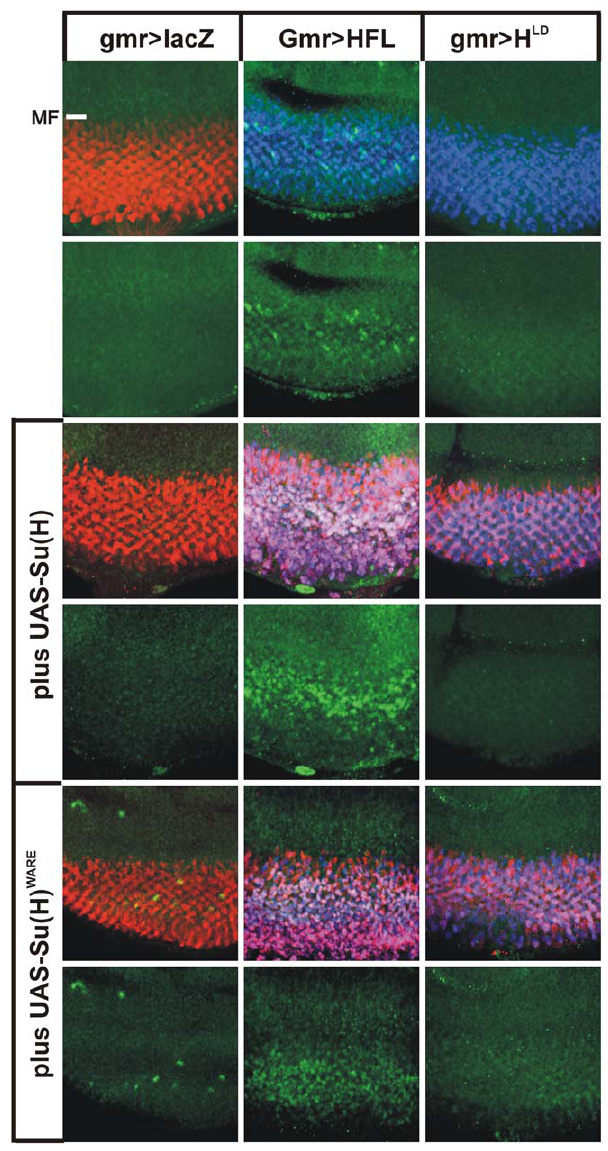
Figure 7. Regulation of apoptosis by Su(H) and Hairless variants during Drosophila eye development. The indicated UAS transgenes were overexpressed alone or in combination using the gmr- Gal4 driver line. As control the UAS-lacZ gene was likewise overex- pressed. Gmr-Gal4 is active in the developing photoreceptor cells that arise posterior to the morphogenetic furrow (MF). Overexpression was visualized with specific antibodies against beta-galacotsidase (red, control), Su(H) (red) and Hairless (blue). In the merge, expression appears magenta. Apototic cells were detected with an antibody directed against activated Caspase 3 (green). A surplus of Hairless induces apoptosis which is strongly enhanced by the combined overexpression with either Su(H) or Su(H) WARE . In contrast, H LD had no such an impact.